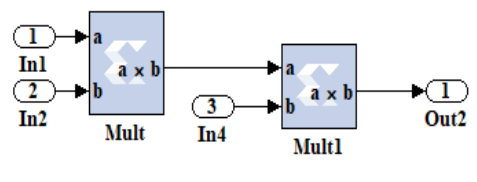
Fig. 16. Pr 1,13,16, and 19 blocks described detail.